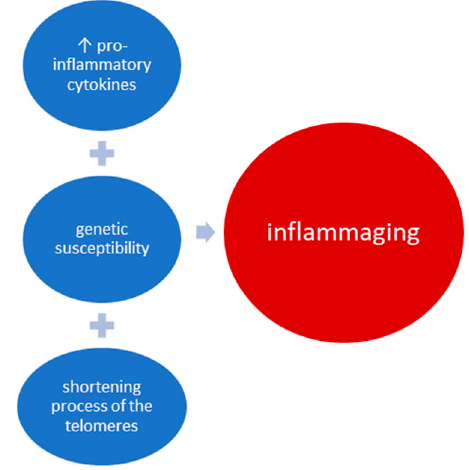
Figure 7. The link between proinflammatory cytokines, genetic susceptibility, and DNA changes that occurs with inflammaging. The etiology of immunosenescence includes genetic, environmental, and immune factors. The damage of innate immunity refers to monocytes, neutrophils, natural killer, and dendritic cells and is characterized by the reduction of phagocytosis and superoxide production. The damage of acquired immunity includes B and T lymphocytes and determines thymus atrophy, increased proinflammatory cytokines, and autoreactivity. High levels of proinflammatory cytokines including IL-6, IL-1, and TNF α have a crucial role in the aging process by creating an inflammatory environment in most of the organs and body tissues. Systemic low-grade inflammation can determine stem cell aging through the activation of the signaling pathways (NF-kB, TOR, JAK/STAT). An important role in the process of replicative senescence and age-related diseases belongs to DNA damage response, which is directly related to telomere shortening. DNA damage response favors proinflammatory status through its action on stem cells, fibroblasts, or macrophages, thus exacerbating the phenomenon of